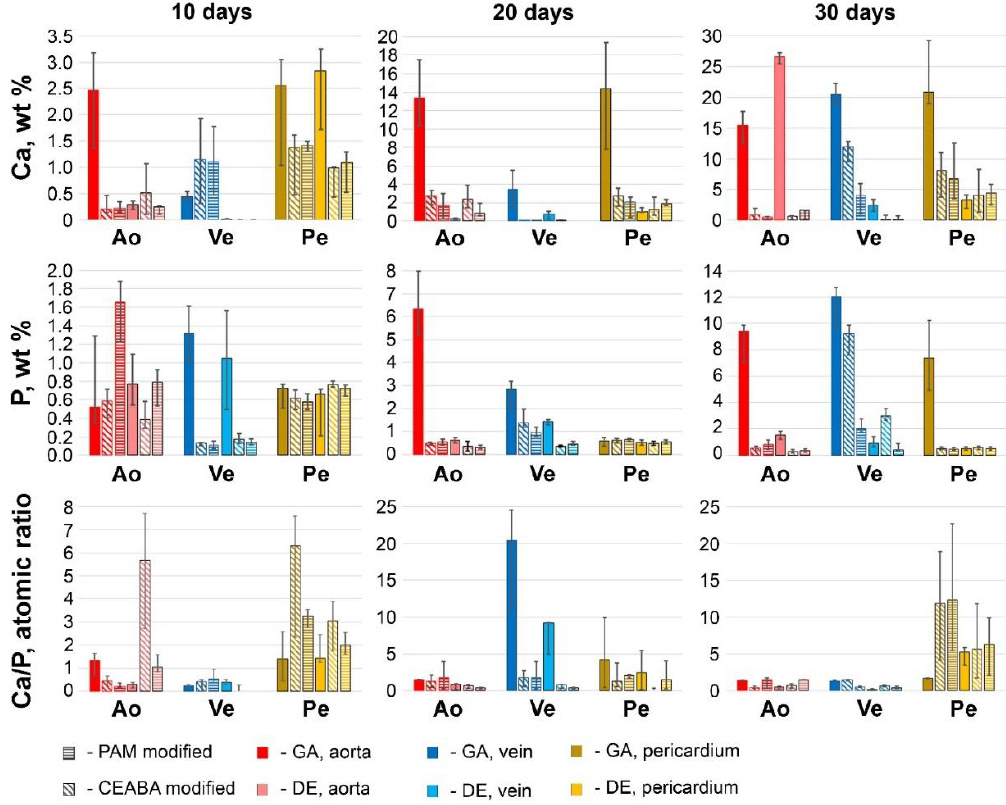
Figure 9. Calcium (Ca) and phosphorus (P) levels (wt%) and Ca/P atomic ratio in electron-dense particles on the implant surfaces.